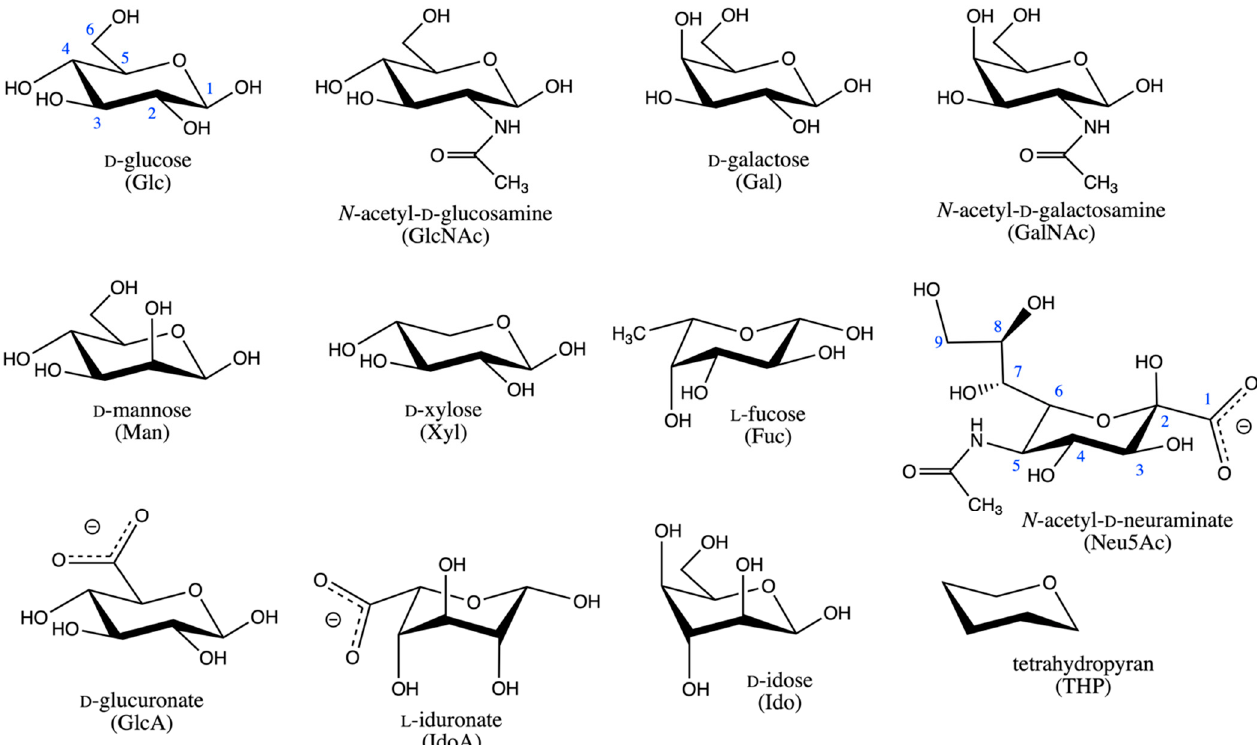
Figure 1. Compounds considered in the current study. Glc carbon atoms are numbered in blue. All other monosaccharides follow the same numbering scheme, except for Neu5Ac, which is numbered as pictured. All monosaccharides are drawn as the β anomer. The α anomer is created by inversion of the configuration at carbon 2 for Neu5Ac and at carbon 1 for all other monosaccharides. Both anomers for each monosaccharide as well as the corresponding O-methyl glycosides, formed by methylation at the anomeric carbon hydroxyl, were studied, for a total of 45 compounds (44 monosaccharides + THP).